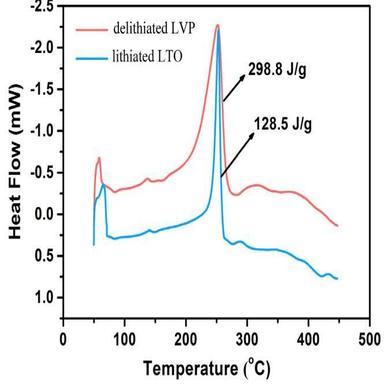
DSC traces of fully lithiated LTO and fully delithiated LVP at 10 °C min−1 with traces of 1 M LiPF6 in EC-EMC-DMC (1:1:1).